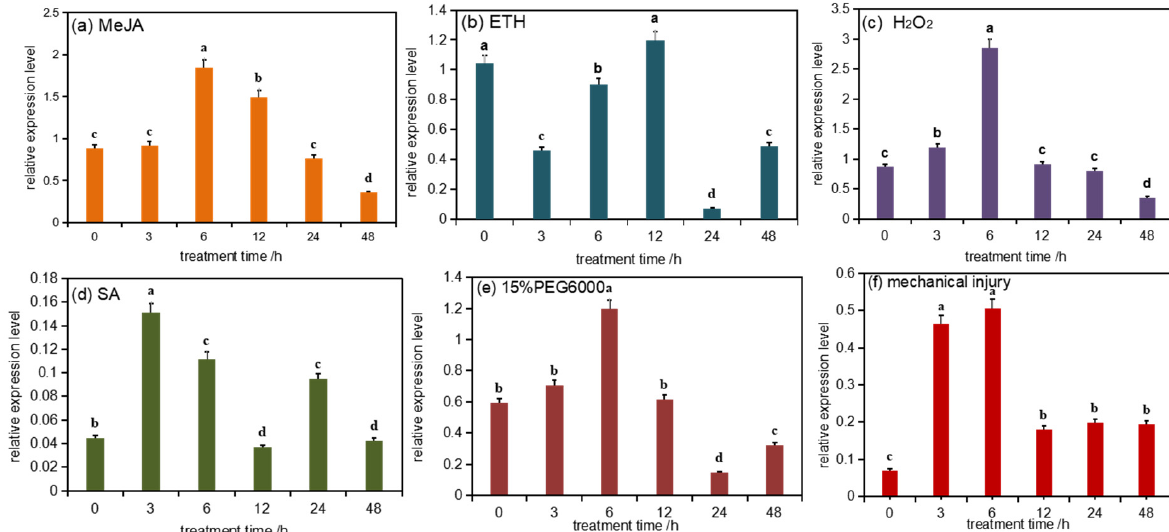
Figure 3. PmDXS expression level in different stress of P. massonniana . Different lowercases in the same column indicate a significant difference, p < 0.05. All the above treatments were treated at 0 h without any treatment as the control group. Figure ( a ) shows the relative expression level under MeJA treatment; figure ( b ) shows the relative expression under ETH treatment; figure ( c ) shows the relative expression under H 2 O 2 treatment; figure ( d ) shows the relative expression under SA treatment; figure ( e ) shows the relative expression under 15 % PEG6000 treatment; figure ( f ) shows the relative expression under mechanical injury treatment.